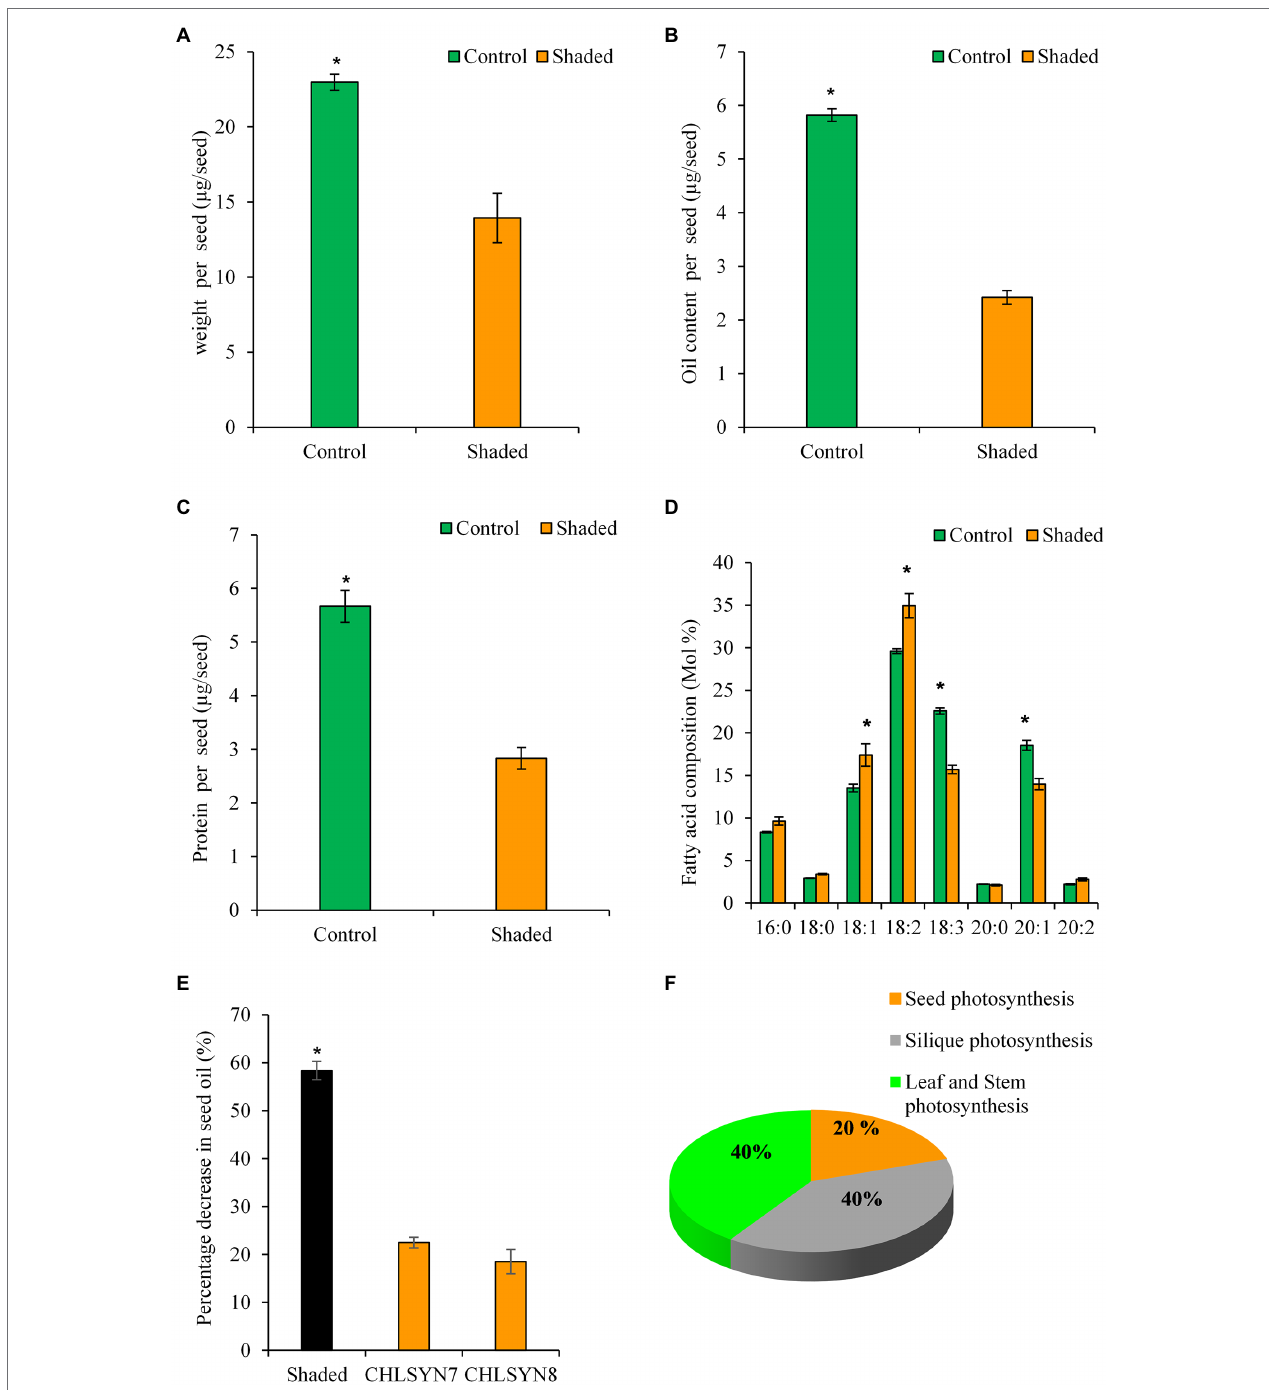
FIGURE 4 | Photosynthetic organ contribution to total oil production in seeds. (A) Analysis of the weight of dry shaded and control seeds (40 DAF). (B) The total oil content of dry shaded and control seeds. (C) The protein content of dry shaded and control seeds. (D) Fatty acid composition of shaded and control seeds. (E) The relative decrease in oil content per plant. (F) Contribution of different photosynthetic tissues to seed oil production (seed chlorophyll ± error = 1.53, silique chlorophyll ± error = 1.97). Values are means ± SD ( n = 3 biological replicates). Green and orange bars indicate control and shaded. Statistical significance was analyzed using the two-sided Student’s t -test. The asterisk indicates a significant difference ( * p <